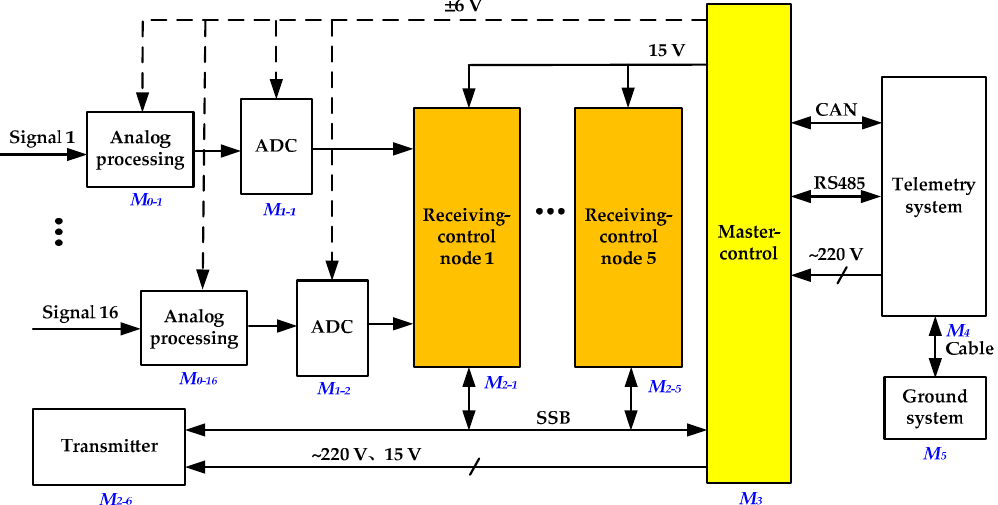
Figure 2. Electrical connections among all subsystems, and route of logging data.